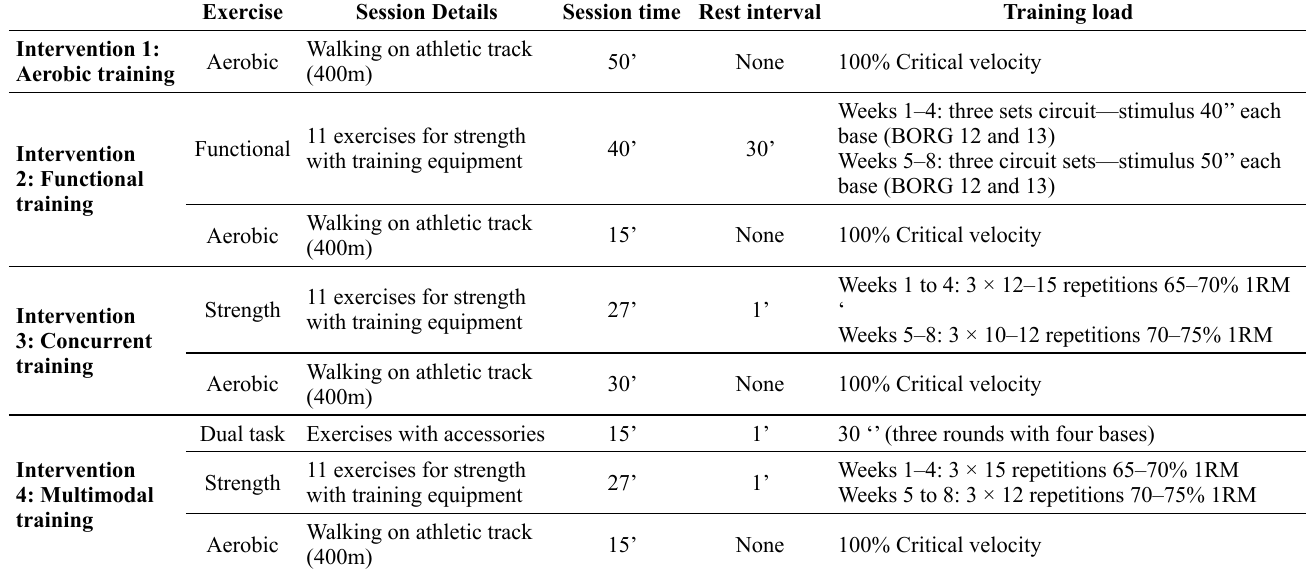
2 Coordination test: The participants sit in front of a table and use their dominant hand to perform the test. Three cans are placed on the table, (on the right for the right-handed individuals and on the left for the left-handers), the participant is required to move the cans to the next position, one by one, considering the reversal of the three cans as one turn. The test consists of four turns (12 cans moved) as a complete circuit. The shortest circuit time is considered for the final result. 3 Flexibility test: The participant sits on the floor with their legs extended, positioned on a tape affixed to the ground. The individual then reaches forward as far as possible and the dis- placement distance is measured while the participant remains in the final position. The subjects have two practical attempts. The final result is the best performance from two attempts. 4 Strength endurance test: With the dominant arm, the par - ticipant contracts the biceps by performing an elbow flexion, performing as many repetitions as possible in 30 seconds. The final result is the best performance from two attempts. 5 General aerobic capacity test: The participant is